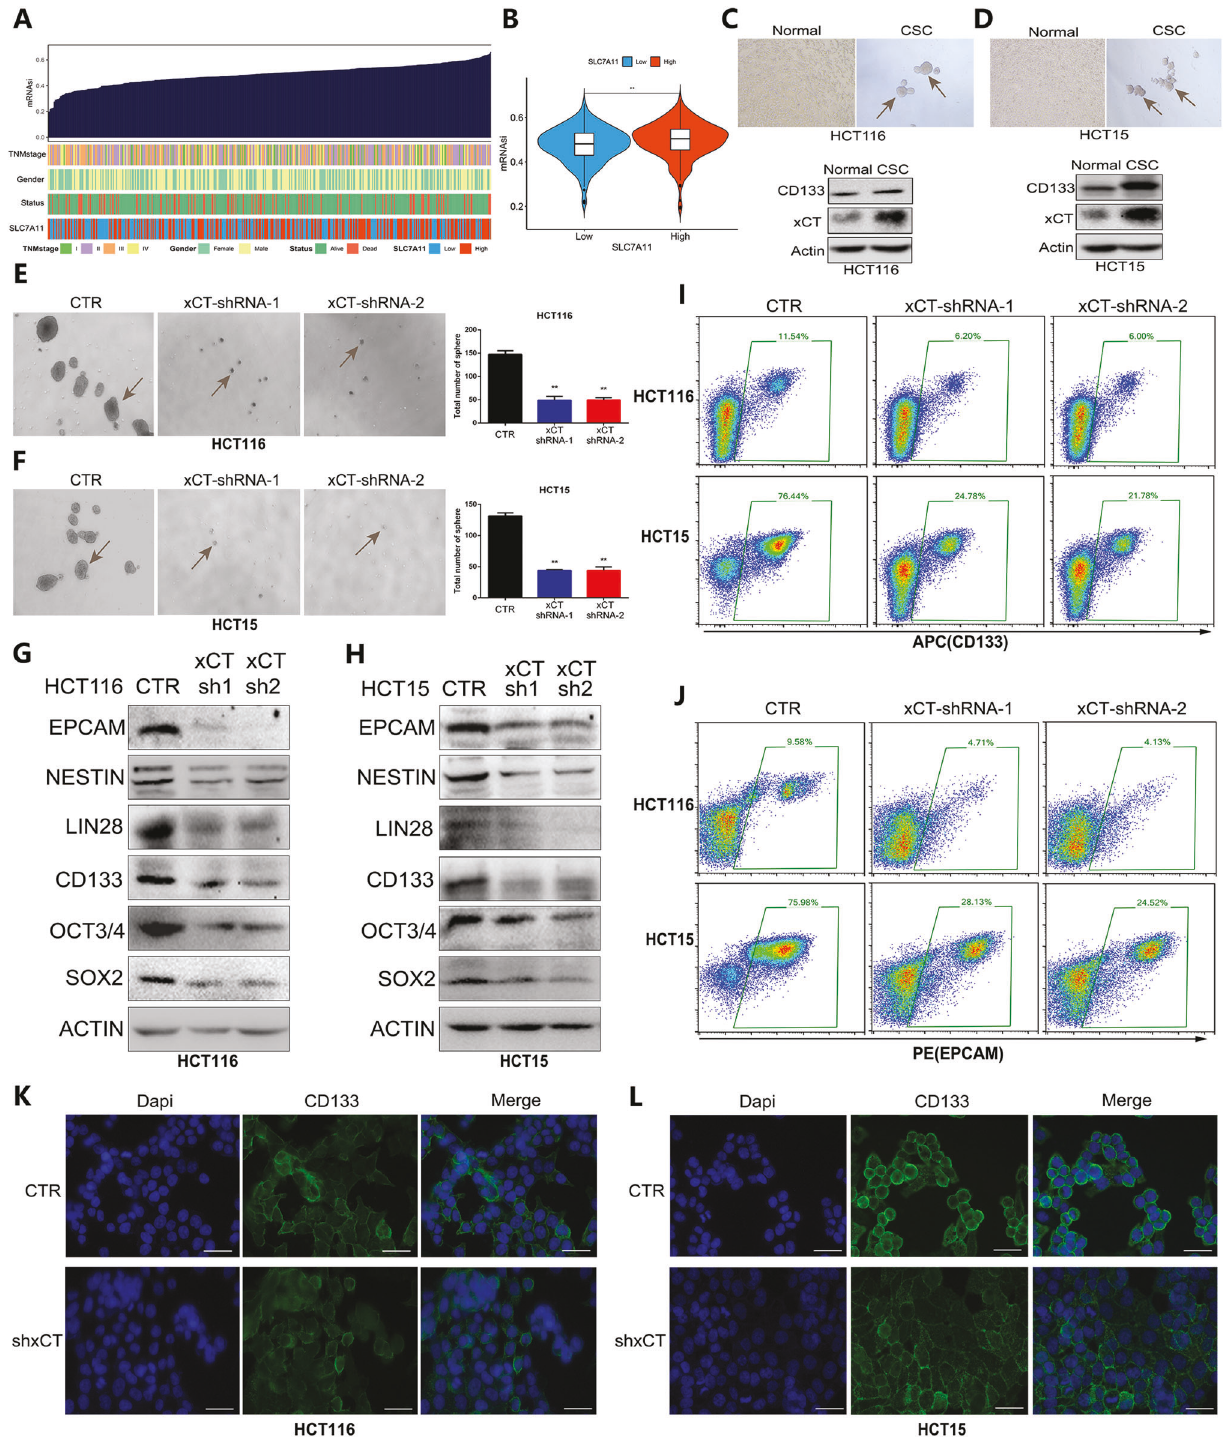
Fig. 4 Effects of xCT knockdown on the stemness of HCT116 and HCT15 CRC cells. A An overview of the correlations between xCT expression, mRNAsi, and known clinical characteristics (TNM stage, sex, and survival status) in the TCGA-COAD cohort. B The association between the expression of xCT and mRNAsi in the TCGA-COAD cohort. C , D Western blot assay was applied to detect the expression of xCT in CRC cells and CRC stem cells. E , F Sphere formation assays showed that xCT inhibition suppressed the sphere-forming capability of CRC stem cells. G , H Western blot analysis showed that xCT knockdown reduced the expression level of stemness-related molecules in HCT116 cells and HCT15 cells. I , J Flow cytometry indicated that xCT inhibition signi fi cantly diminished the expression of EPCAM and CD133 in CRC cells. K , L IF staining showed that xCT knockdown suppressed the expression of CD133 in CRC cells. ** P < 0.01.